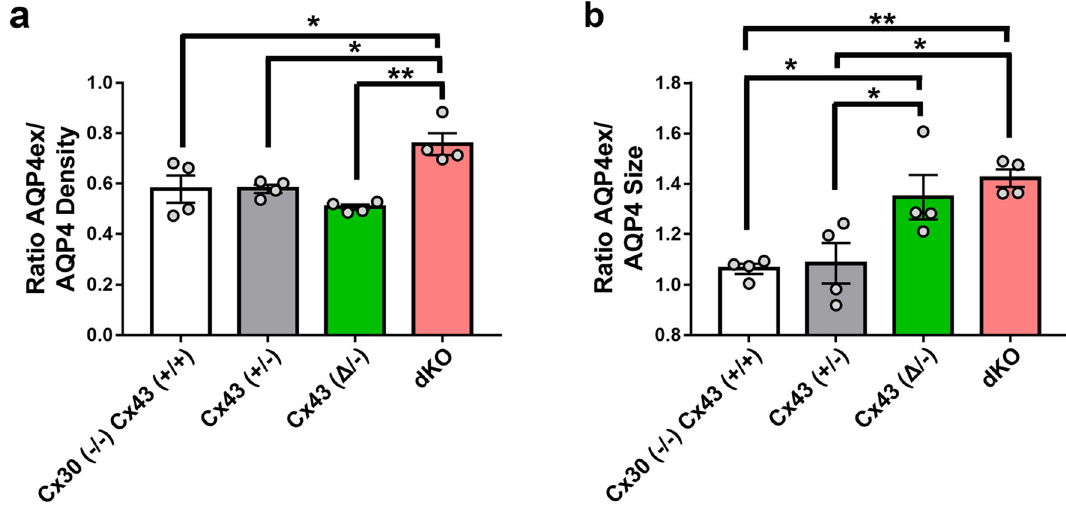
Figure 7. Ratio of AQP4ex/AQP4 density and size in perivascular brain regions of the Cx43 genotypes. ( a ) Ratios of particle densities of AQP4ex to AQP4 shows that dKO has higher ratio than the other genotypes. ( b ) Ratios of particle sizes shows that Cx43 (+/+) and Cx43 (+/−) are similar but the size of AQP4 is smaller than AQP4ex for the other groups. Data are presented as mean ± SEM (ANOVA followed by Tukey’s post hoc test: * p < 0.05 and ** p <